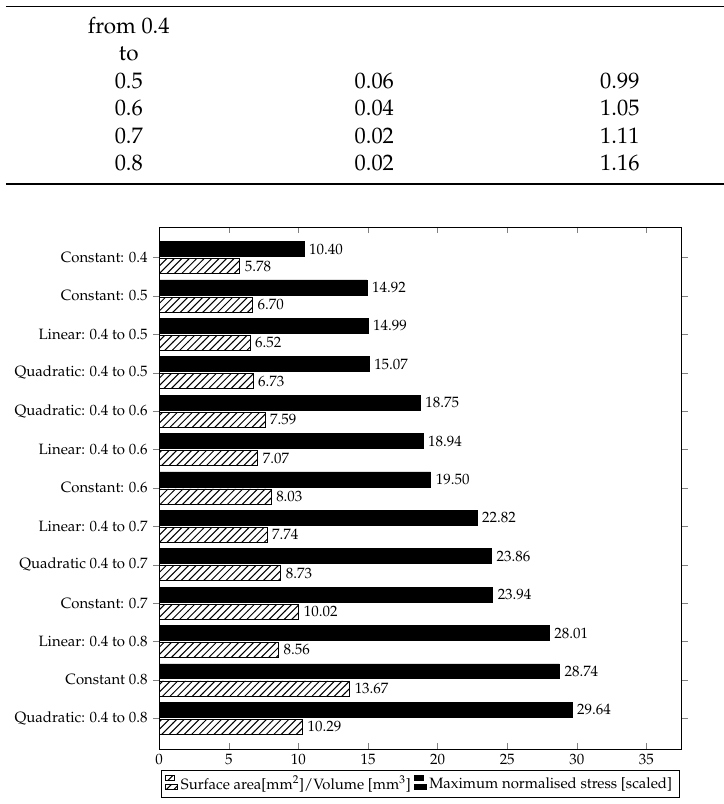
Figure 6. Dimensionless, scaled maximum normalised stress σ VM,max [scaled] of gyroid structures in ascending order, in comparison to the SA/V ratio of the same